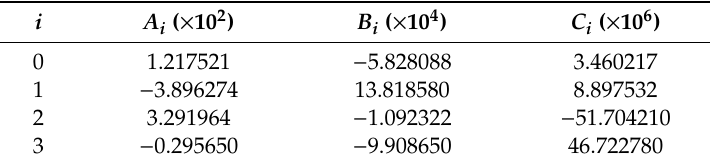
Table A6. Values of A i , B i , and C i for viscosity.